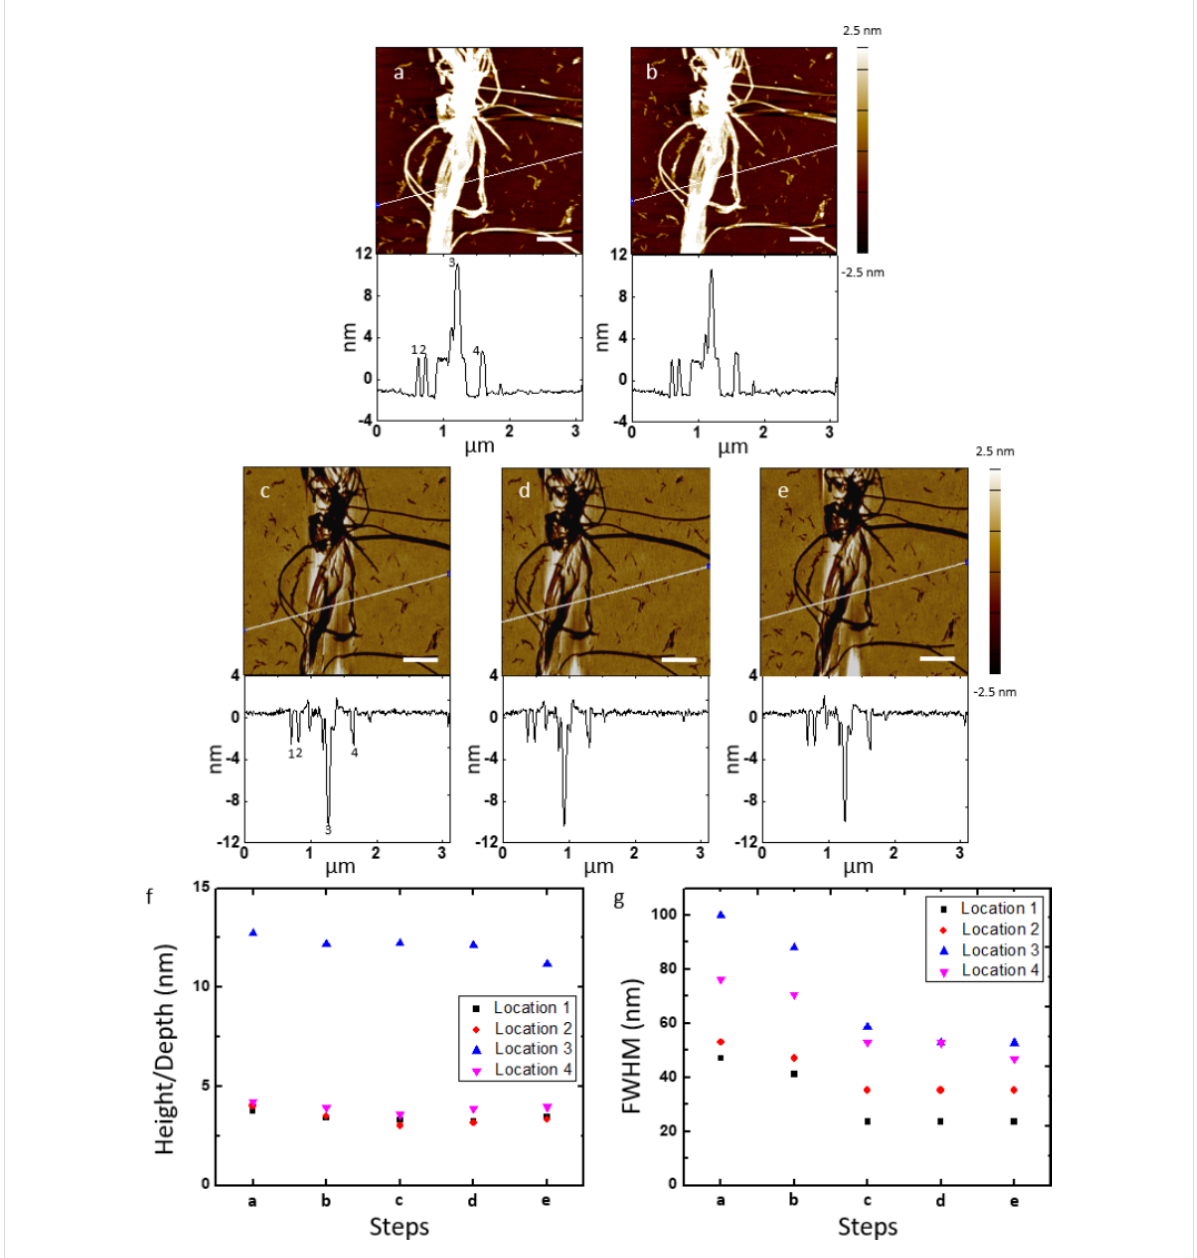
Figure 2: Comparison of features on a DNA nanotube master template with a ca. 2 nm thick Al 2 O 3 film and a PLLA stamp, and stability of features on a PLLA stamp of the same area. AFM height images and corresponding cross-sectional analysis of DNA nanotubes after (a) deposited on a silicon wafer and (b) 20 cycles of ALD of Al 2 O 3 (ca. 2 nm of Al 2 O 3 film), and the negative replicas on a PLLA stamp imaged (c) 1, (d) 8, and (e) 15 days after pattern transfer of the same area. White lines on the AFM images indicate where the cross-sections were determined. (f) Height/depth and (g) FWHM of the DNA nanotubes and their replica trenches in four different locations of the AFM images from (a) to (e). Locations 1, 2, 3, and 4 correspond to 1, 2, 3, and 4 in the cross-sections of the AFM images (a) and (c). Scale bars represent 500 nm. Note: The AFM images from (c) to (e) are mirror-flipped to match the orientations of the AFM images (a) and